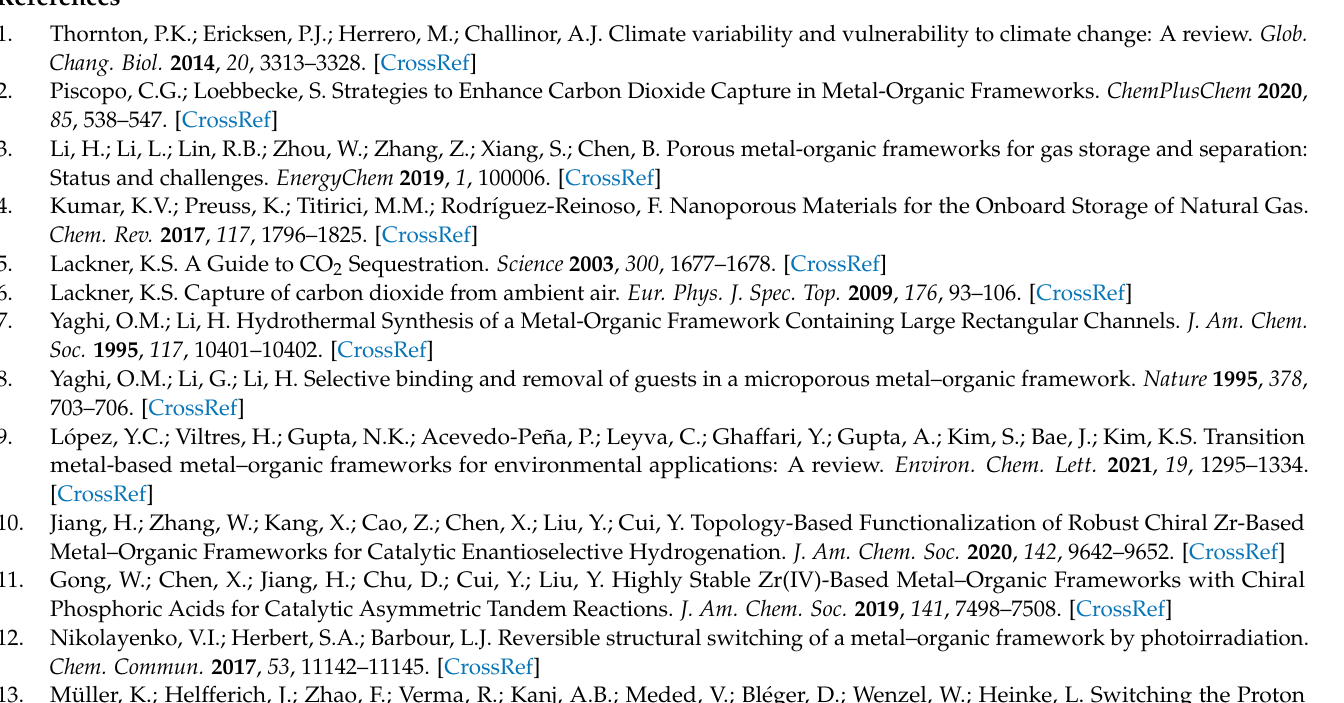
Table S6: Selected angles [ ◦ ] for 3 ; CIF files of 1 , 2 and 3